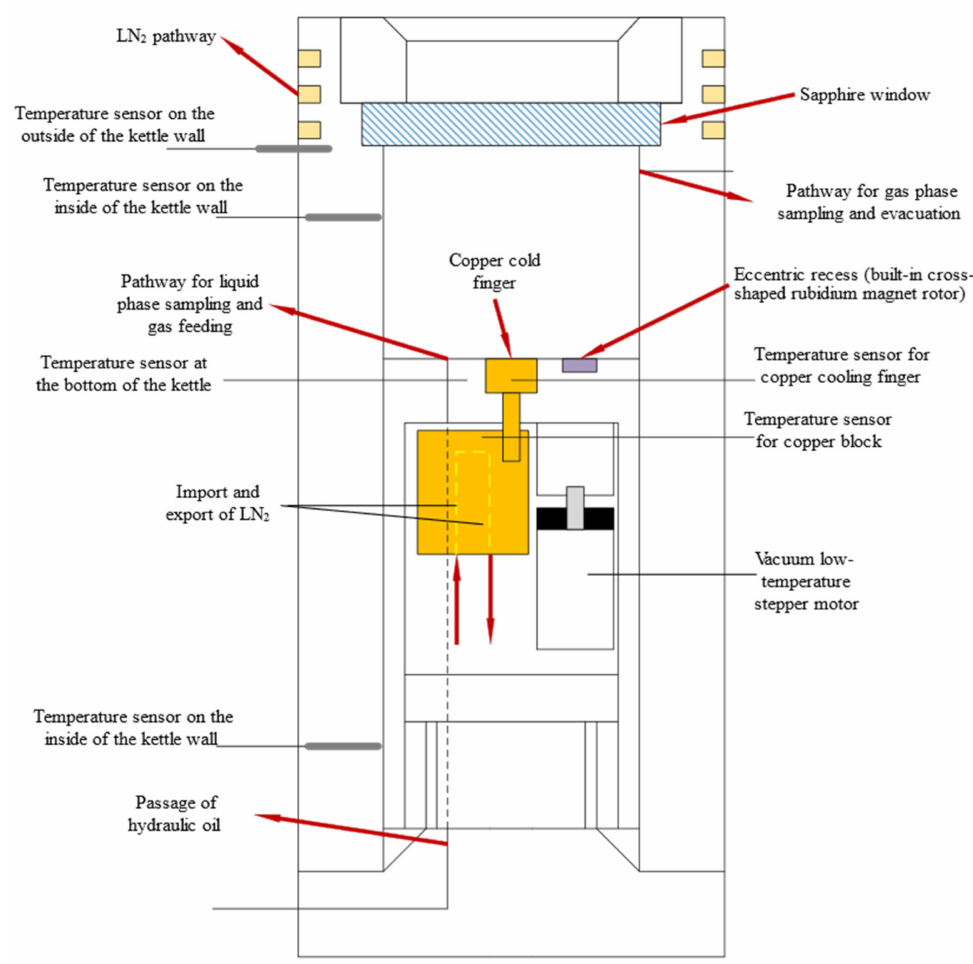
Figure 8. Reaction kettle labelled schematic